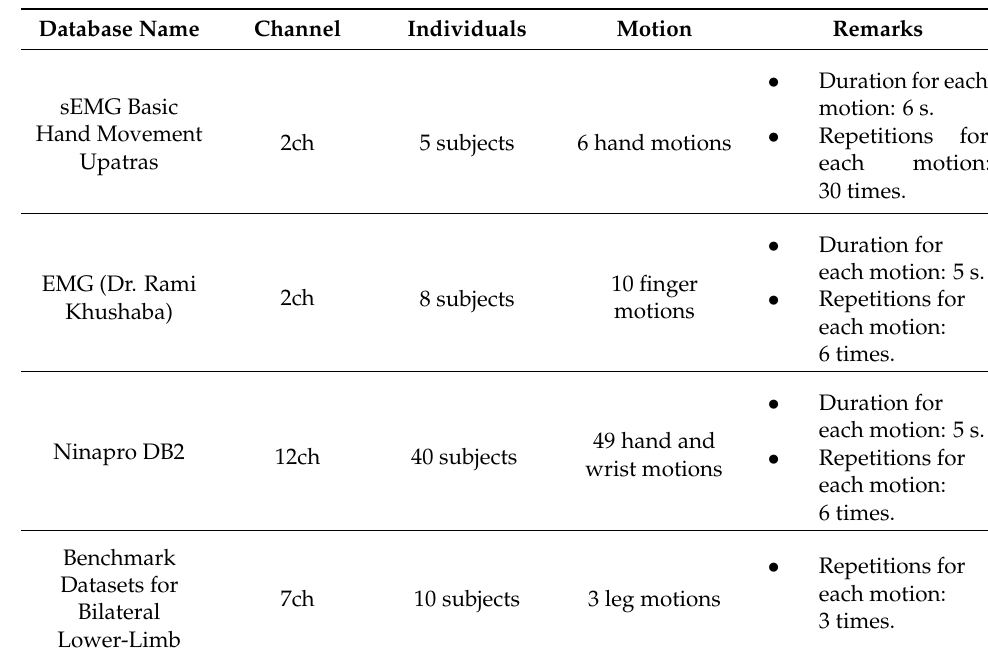
Table 1. sEMG open